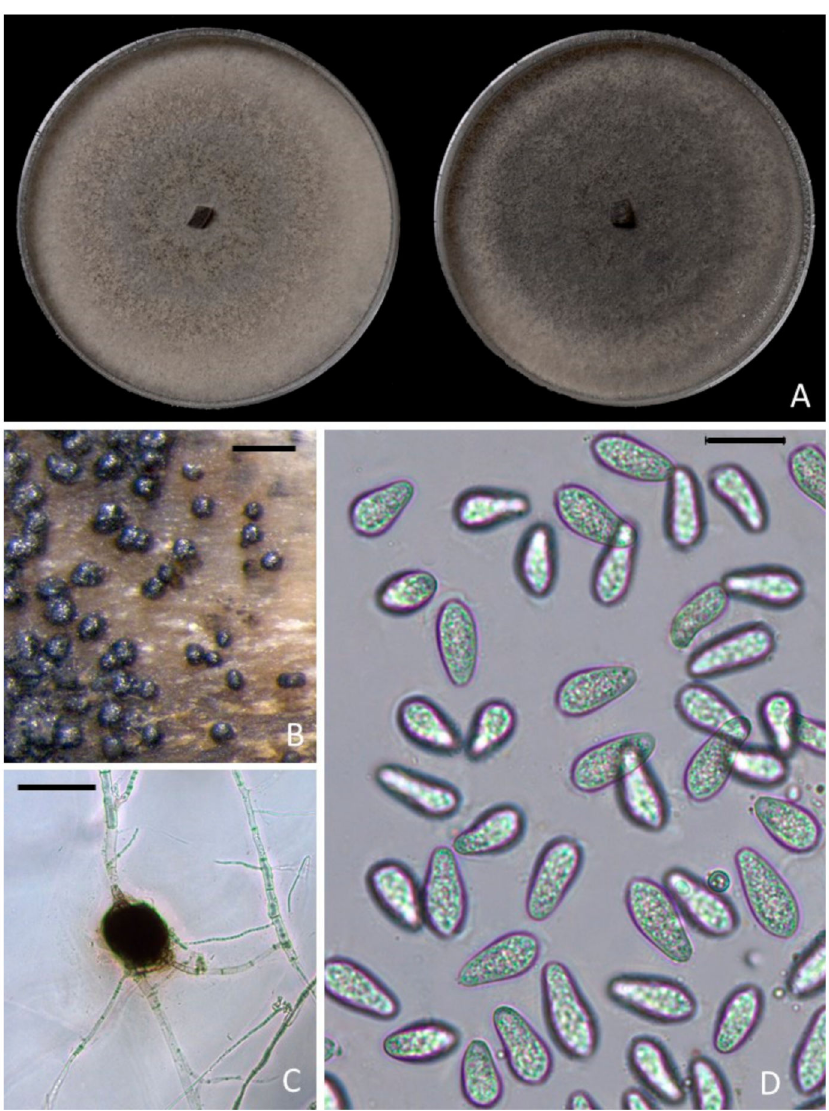
Figure 3. Morphological characteristics of Macrophomina phaseolina ; ( A ) colonies on potato dextrose agar after 10 days of incubation at 25 ± 1 ◦ C in darkness; ( B , C ) microsclerotia on pistachio wood and close up on a microsclerotium produced on water agar; ( D ) conidia produced from mature pycnidia forming on pistachio leaf agar medium. Scale bar in B = 300 µ m; in C = 60 µ m; and in D = 20 µ